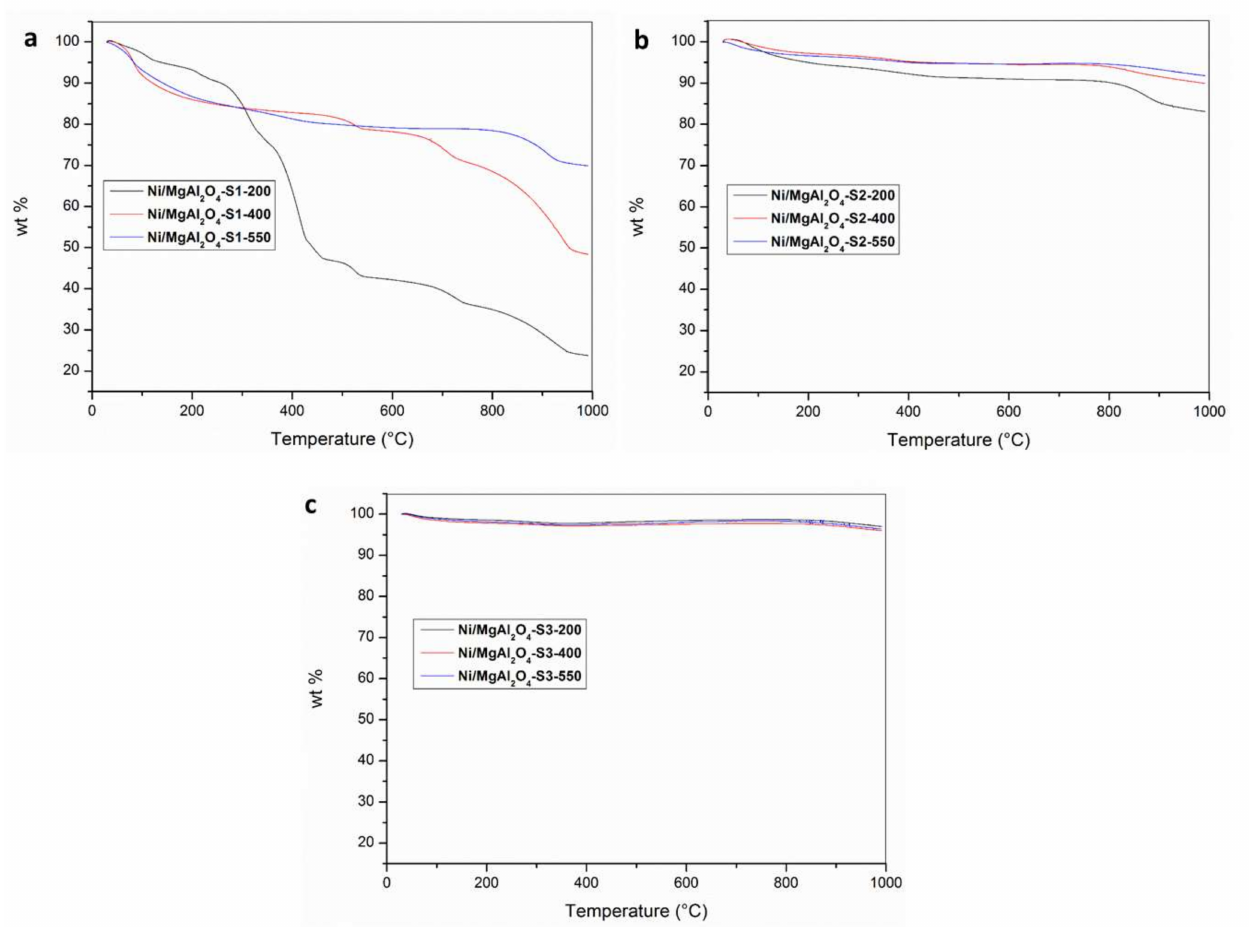
Figure 2. TGA profiles of catalysts sulfided with ( a ) (NH 4 ) 2 SO 4 . ( b ) (NH 4 ) 2 S, and ( c ) DMSO at 200 ◦ C, 400 ◦ C, and 550 ◦